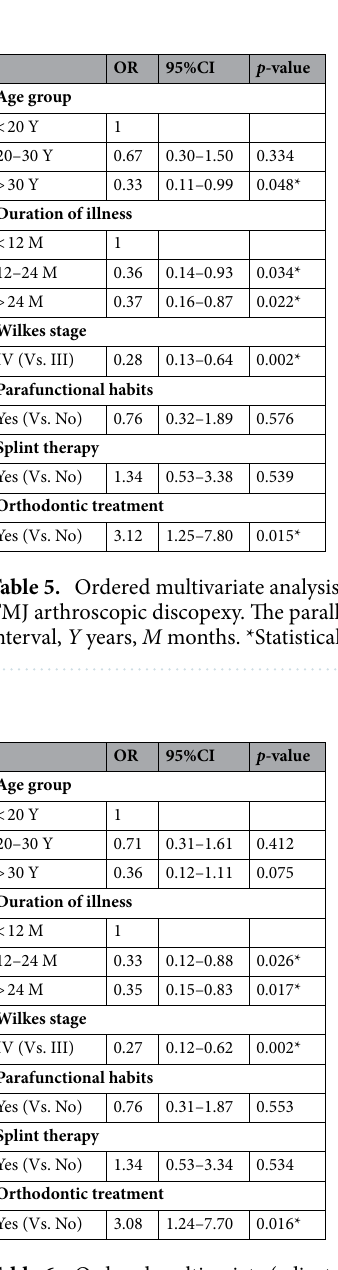
Table 6. Ordered multivariate (adjusted) with prognostic variables and surgical outcomes of the TMJ arthroscopic discopexy. The parallel assumption hold ( p = 0.191 > 0.05). OR Odds ratio, CI Confidence interval, Y years, M months. *Statistically